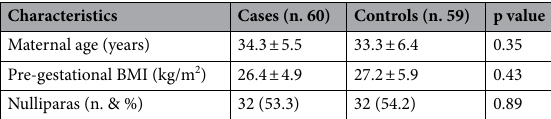
Table 1. Characteristics of the study